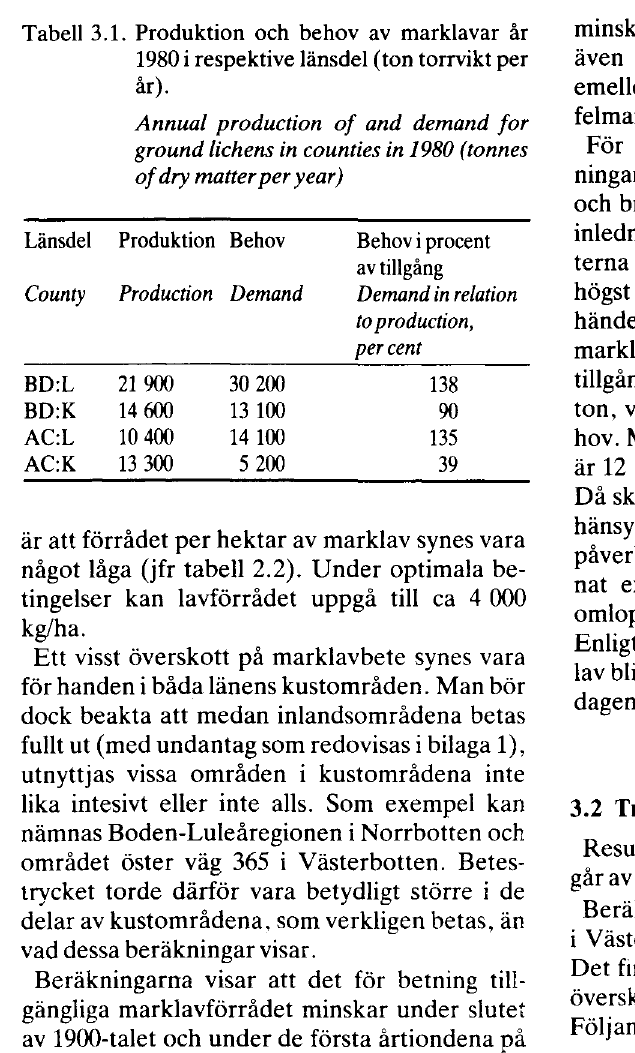
Tabell 3.1. Produktion och behov av marklavar år